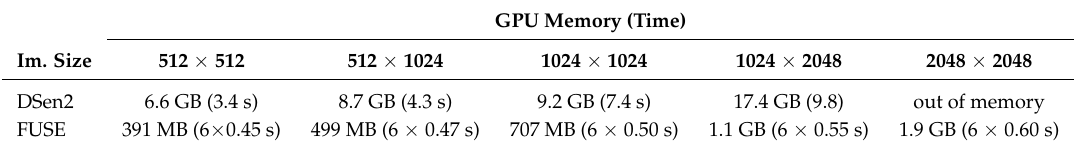
Table 5. Computational burden of FUSE and DSen2 at test time for different image